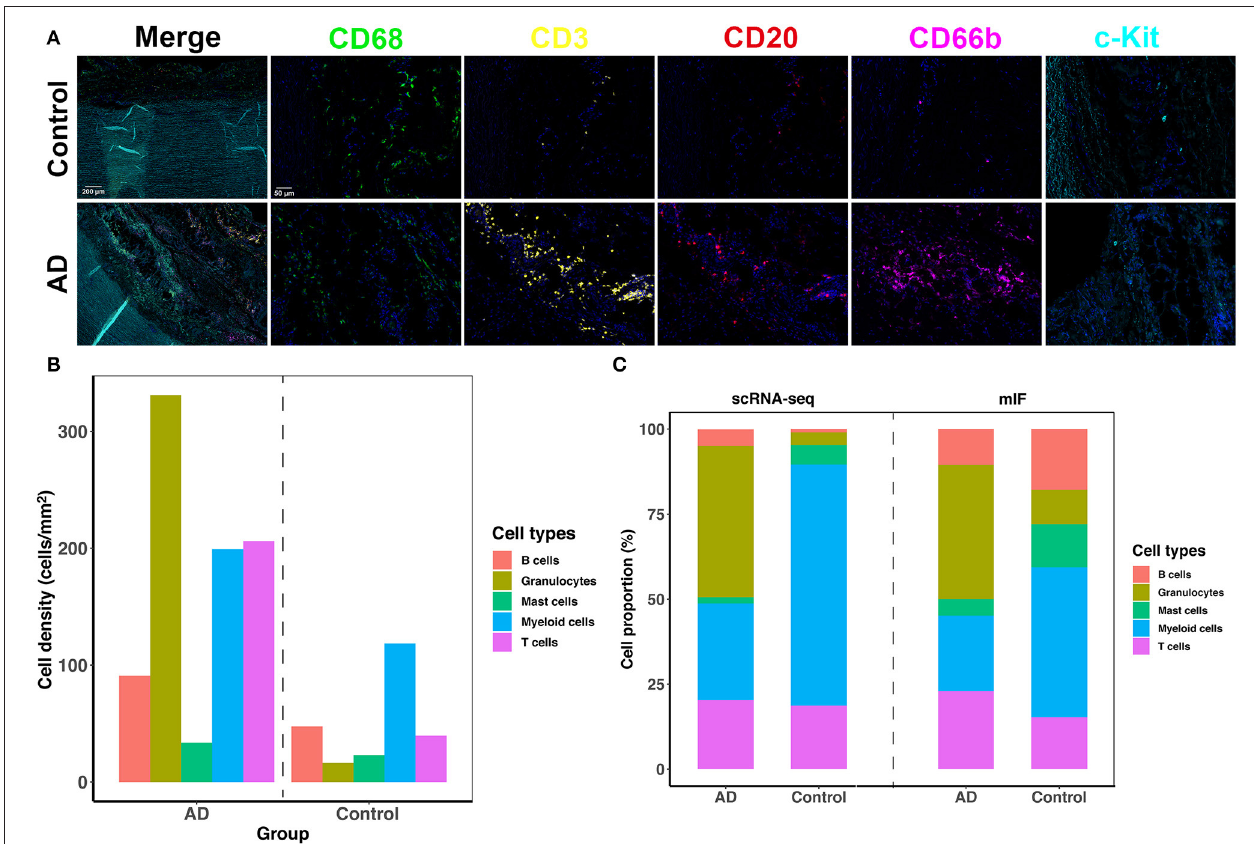
FIGURE 7 | The five-plex mIF assay was performed in control and dissected aortas to validate the proportion of immune cells. (A) Representative mIF images of normal and dissected human ascending aortas stained with CD68 (green), CD3 (yellow), CD20 (red), CD66b (magenta), and c-Kit (cyan). (B) Bar graphs showing increased cell density of all five immune cell types in the AD tissue. (C) Bar graphs showing the percentage of immune cell populations from normal and dissected aortas identified by scRNA-seq analysis (2 bars on the left) or with mIF analysis (2 bars on the right). mIF: multiplexed